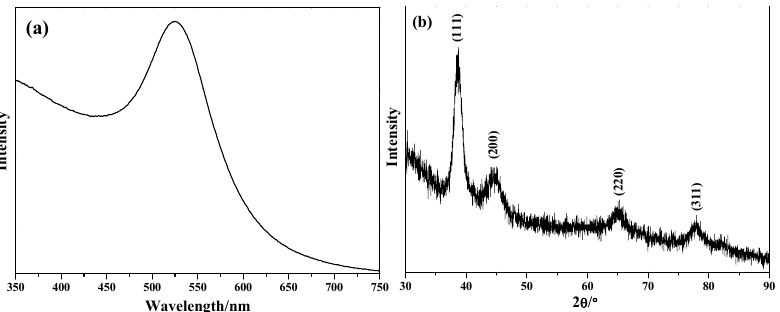
Figure 2. ( a ) UV-vis absorption spectra and ( b ) XRD pattern of Au NPs obtained using toluene as solvent at 120 °C.